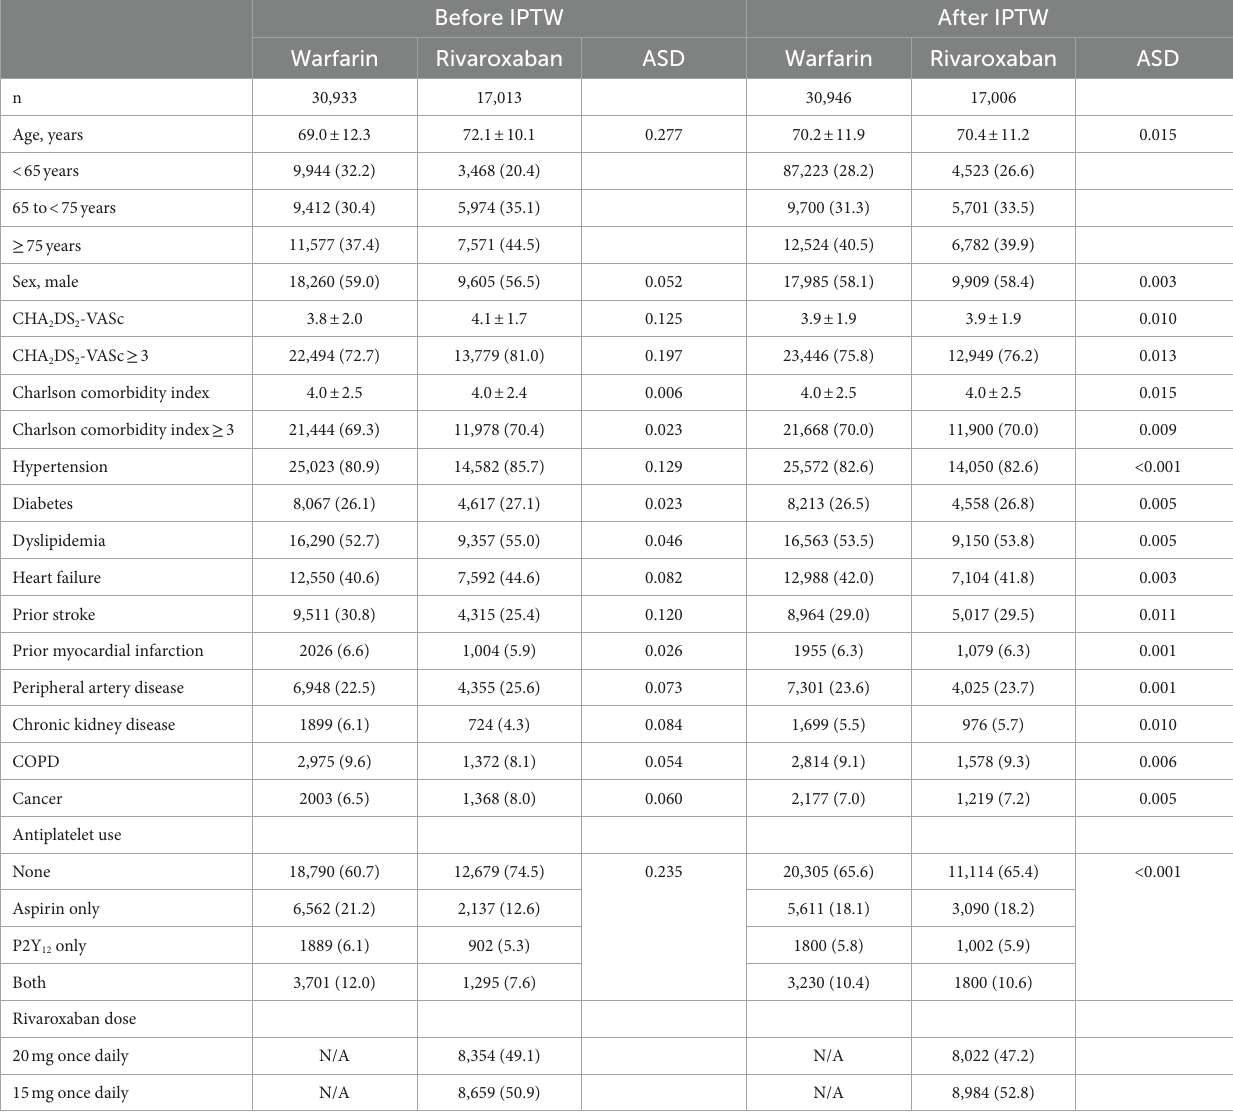
TABLE 1 Baseline characteristics of warfarin and rivaroxaban groups before and after inverse probability of treatment weighting